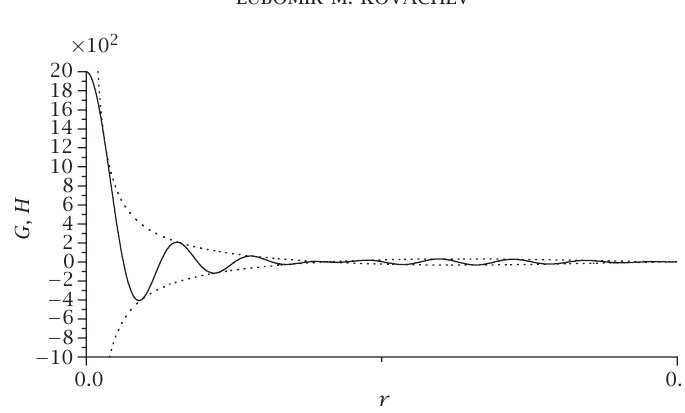
Figure 10.2 . Radial distribution of the envelop solutions G(r) of NDEs (dot- ted line) and the corresponding real magnetic field H(r) (solid line). The real field tends to finite value in the